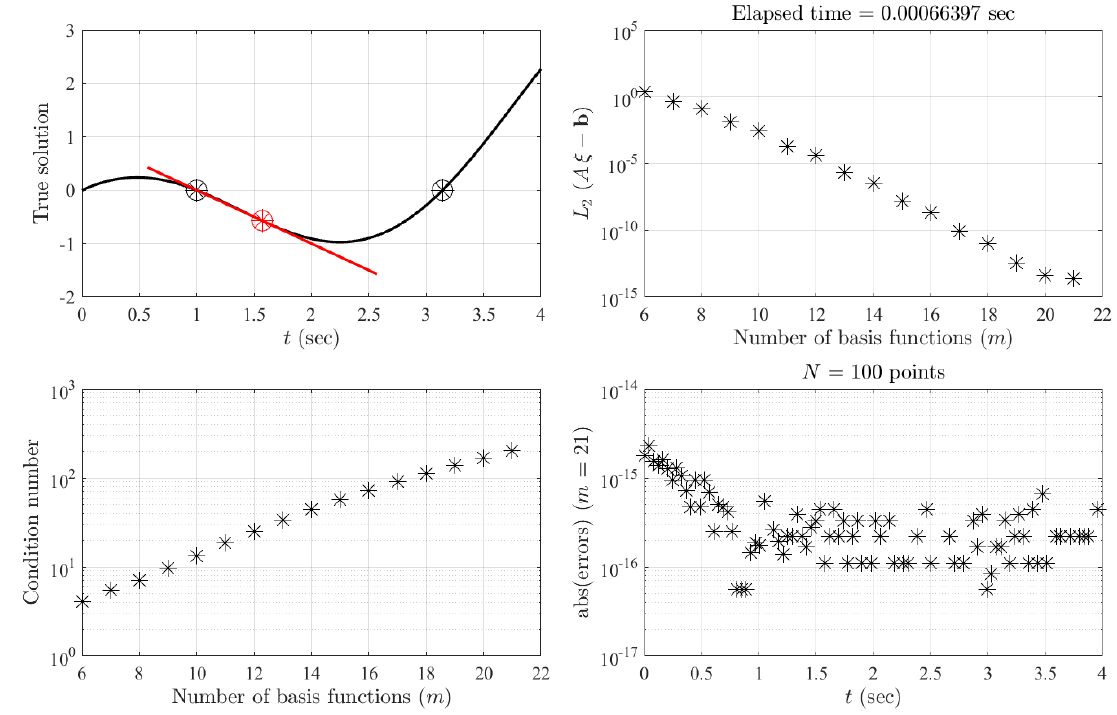
Figure 6. Multi-point value problem example